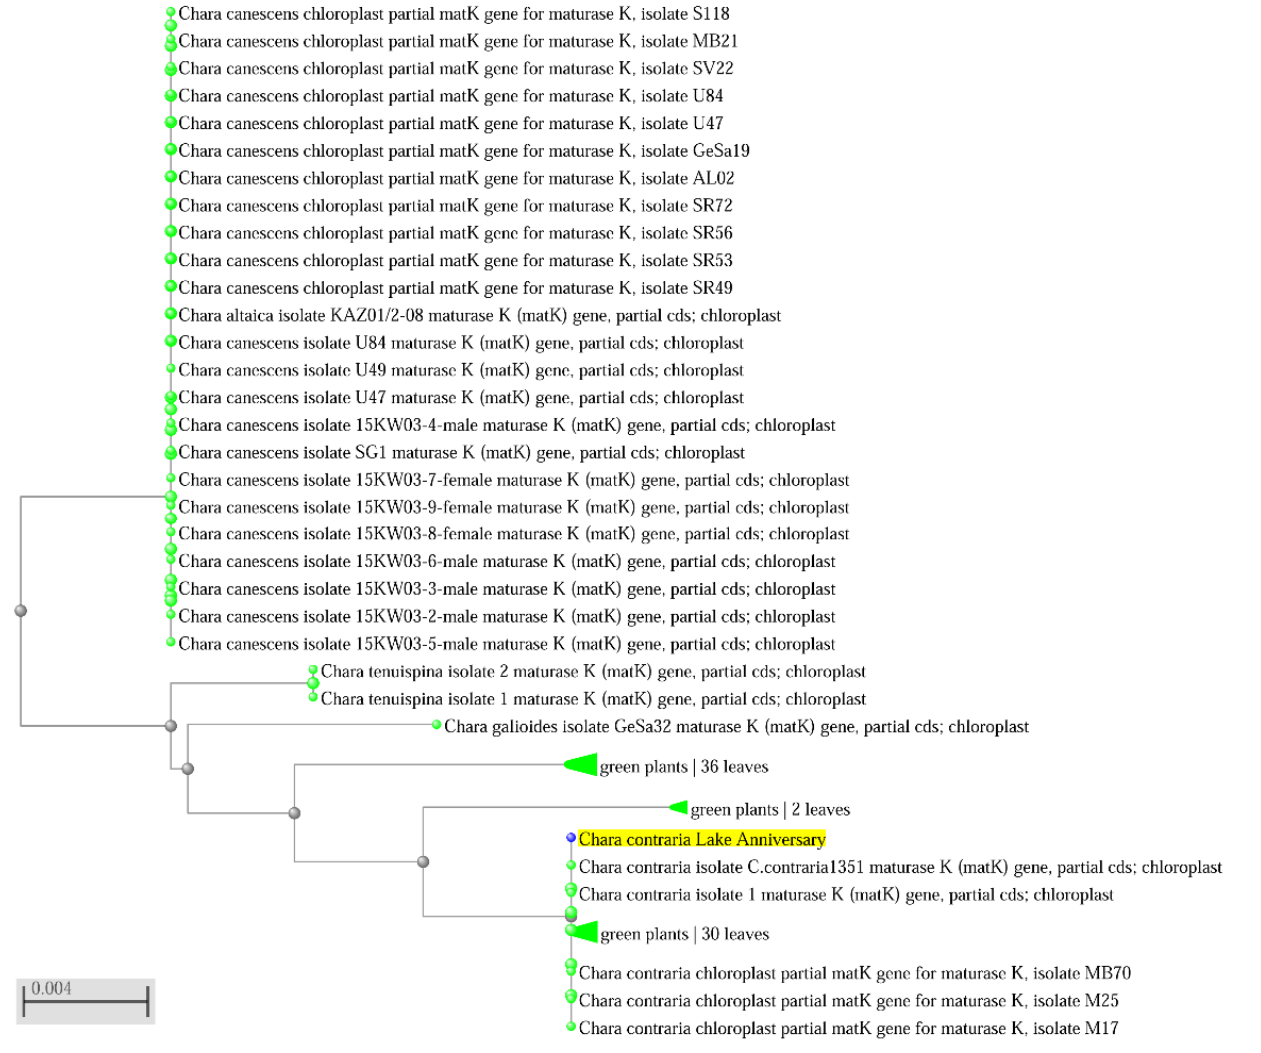
Figure 7. Maximum Likelihood tree of the mat K gene of Chara spp. Bootstrap values above 97 are included. The scale bar indicates 0.4% sequence divergence. Sample AA 25-1 Chara contraria highlighted by yellow is from The Anniversary Lake, site 25; sequences were obtained from herbarium material. The taxon name and NCBI GenBank number are provided.